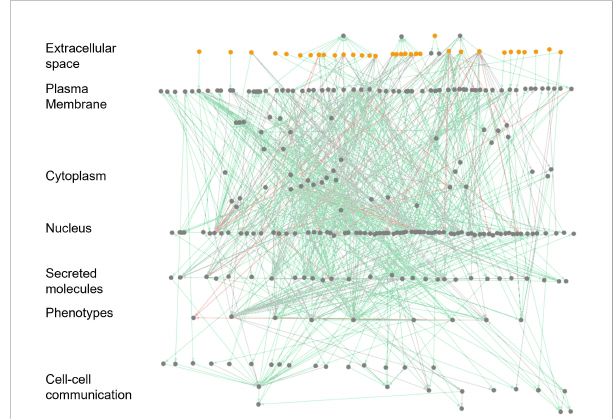
FIGURE 2 Visualization of the large-scale DC model in Cell Collective. The network view of the model. Dots represent signaling molecules; edges represent interactions between the model components. Red edges represent the inhibitions, while green and gray edges show activatory interactions. External (stimuli) and internal components are colored yellow and gray,